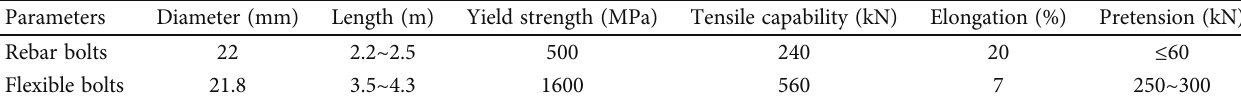
Figure 7: Flexible bolts. (a) Type I in which pretightening force is applied through the lockset. (b) Type II in which pretightening force is applied through the nut. Table 2: Comparison of bolt performance parameters commonly